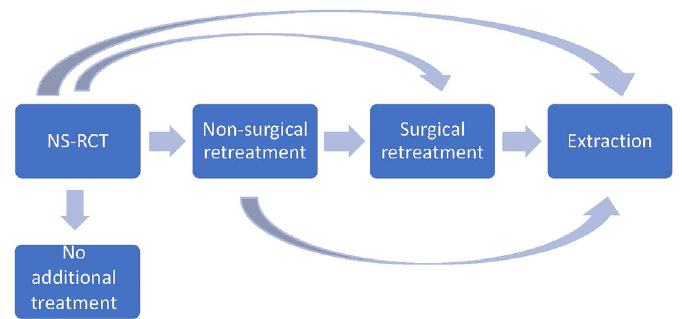
Figure 1- Multi-state model for transitions after NS-RCT